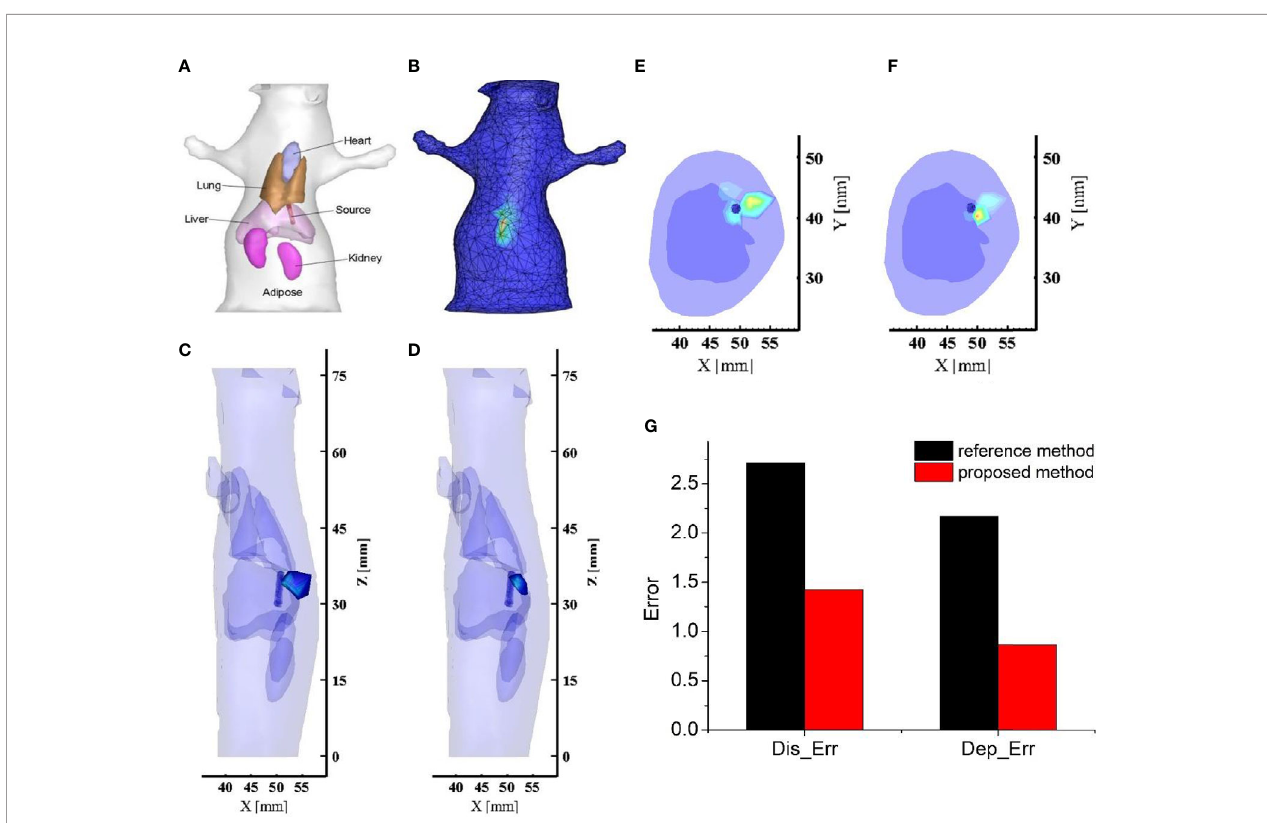
FIGURE 4 | The reconstructed results and related quantitative analysis for the mouse based in vivo experiment. (A) Physical model of the mouse; (B) Light fl ux distribution on the mouse surface. (C, D) The 3D view of reconstructed images obtained by the reference method and the proposed method respectively; The long blue cylinder is the actual light source obtained by m CT, and the colored tetrahedrons are the reconstructed source; (E, F) The cross-sectional view of reconstructed images obtained by the reference method and the proposed method respectively. (G) The quantitative analysis of these reconstructed results. The black bars represent the quantitative indicators of the reference method, and the red bars are those of the proposed method.